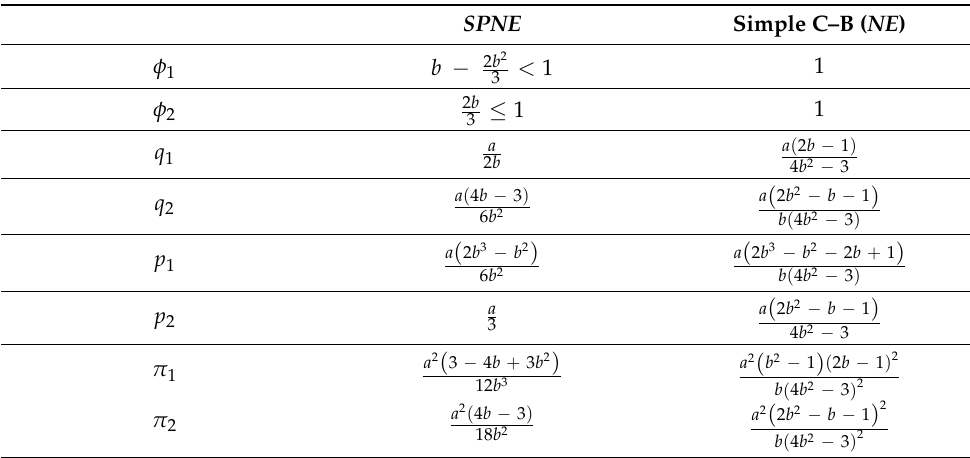
Table 3. Equilibrium values in the Cournot–Bertrand (C–B) model: SPNE-A . SPNE Simple C–B ( NE